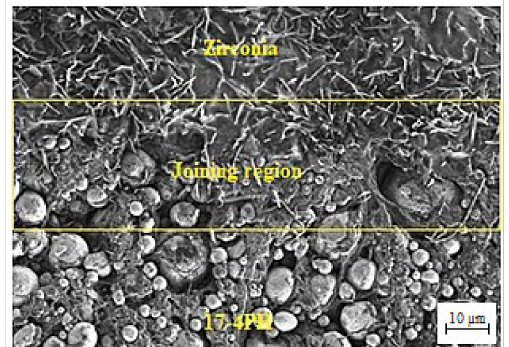
Figure 4. FESEM image of the green 17-4PH/zirconia micro-specimen.